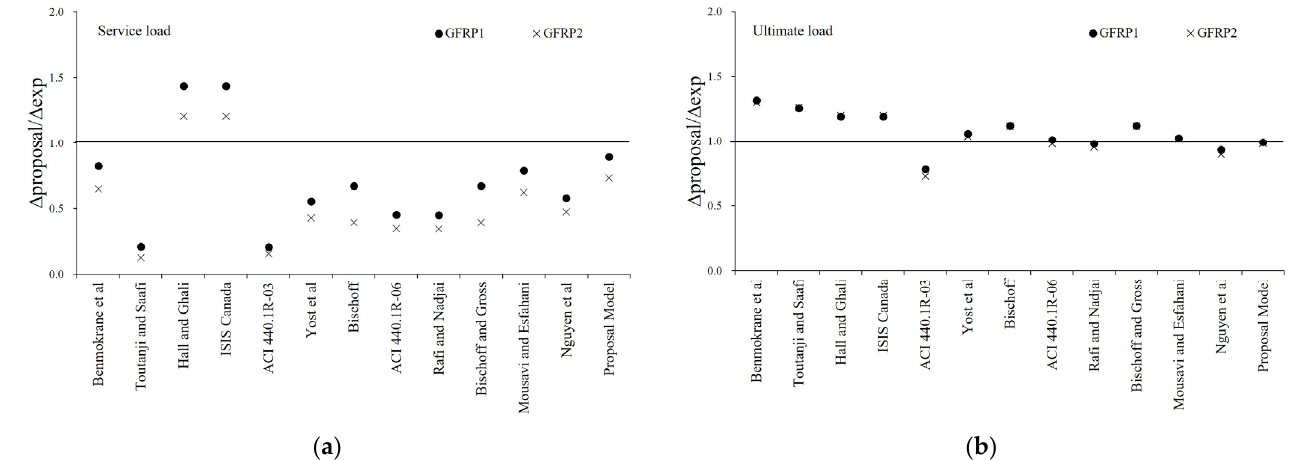
Figure 7. Experimental versus predicted midspan deflection of GFRP Specimens: ( a ) Ratio of experimental and predicted deflection at service load; ( b ) Ratio of experimental and predicted deflection at ultimate load.